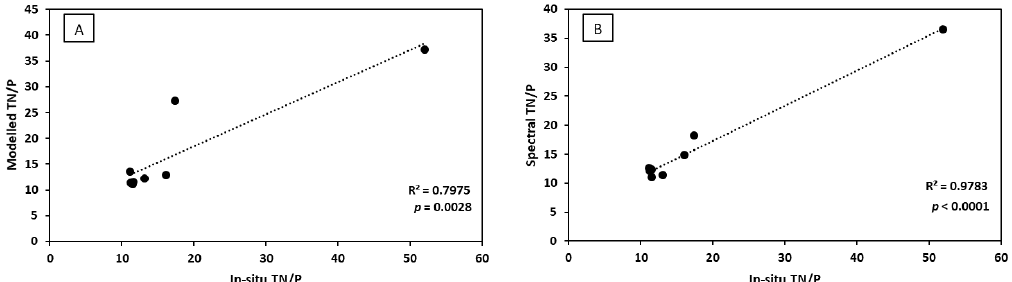
Figure 8. The relationship between the in-situ TN/P, and ( A ) modelled TN/P, and ( B ) Spectral TN/P.